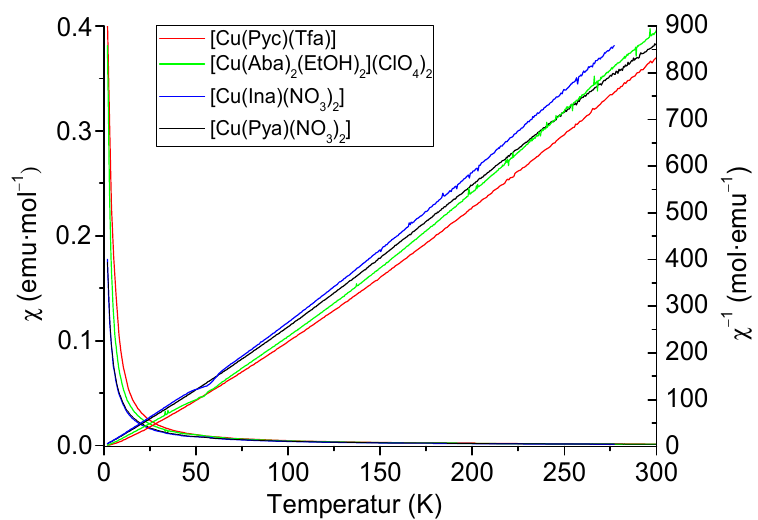
Figure 7. Thermal dependence of χ and χ − 1 of selected Cu II compounds. Table 4. Magnetic moments and Curie-Weiss constants of selected Cu II compounds.